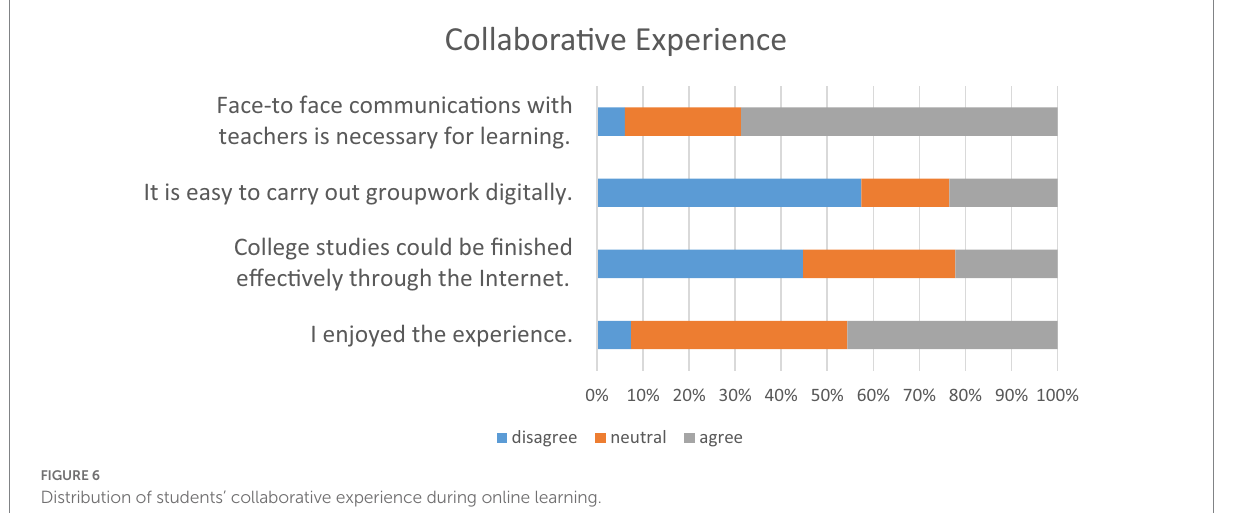
FIGURE 6 Distribution of students’ collaborative experience during online